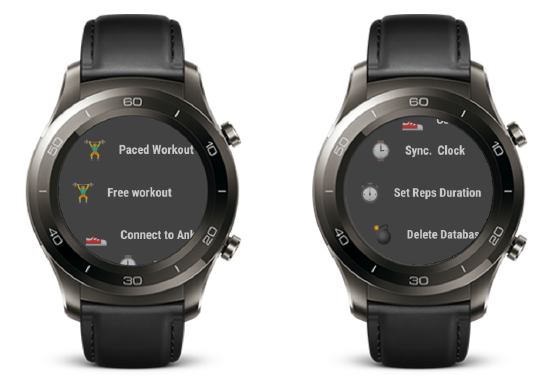
Figure 2. Main menu screen. Participants choose the workout type and set the vibration interval